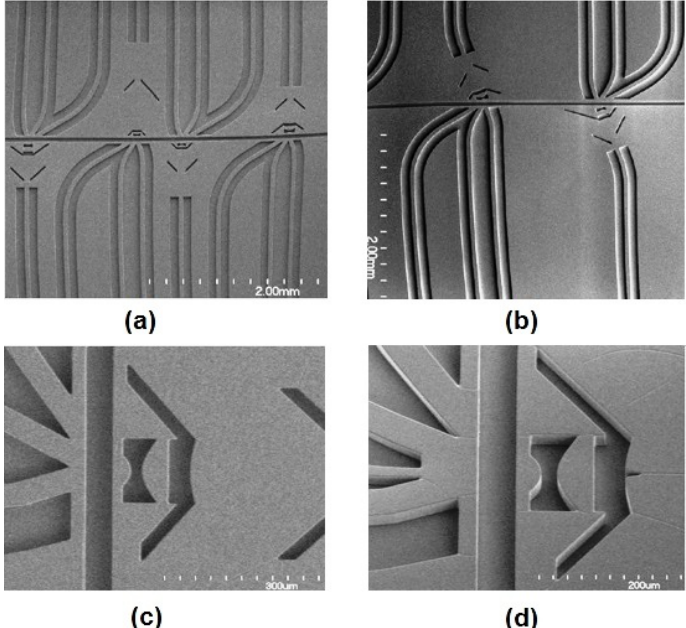
Figure 5. ( a ) SEM images of four microflow cytometers with different optical systems. Long straight waveguides direct lights to the lens system; waveguides at different angles are used to collect signals. ( b ) Images of angled input waveguides and the lens system to reduce background noise for SSC and FSC detection. ( c ) SEM images of on-chip air lens system without notches. ( d ) SEM images of on-chip air lens system with notches. Reproduced from Watts [65] with